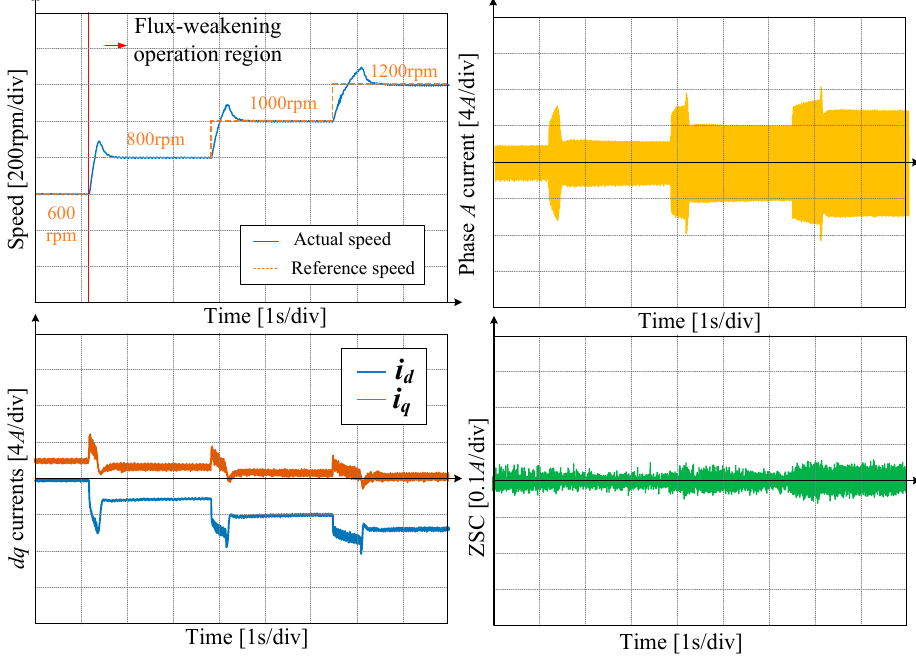
Figure 21. Dynamic performance of FW-DFVL under 0.6 Nm.